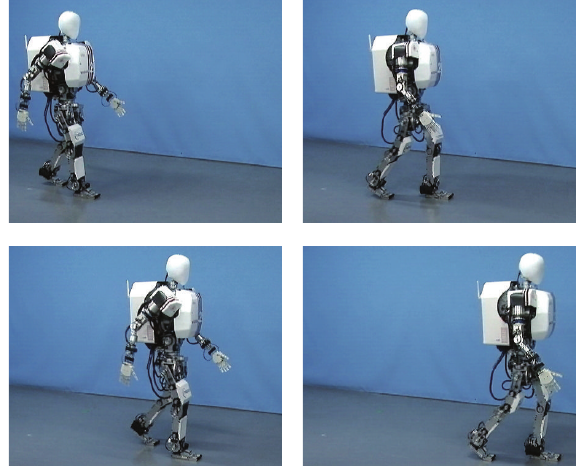
Figure 11: WABIAN-2R’s attitude angle and the modification angle of a swing foot about the roll axis with 30 mm breadth feet.